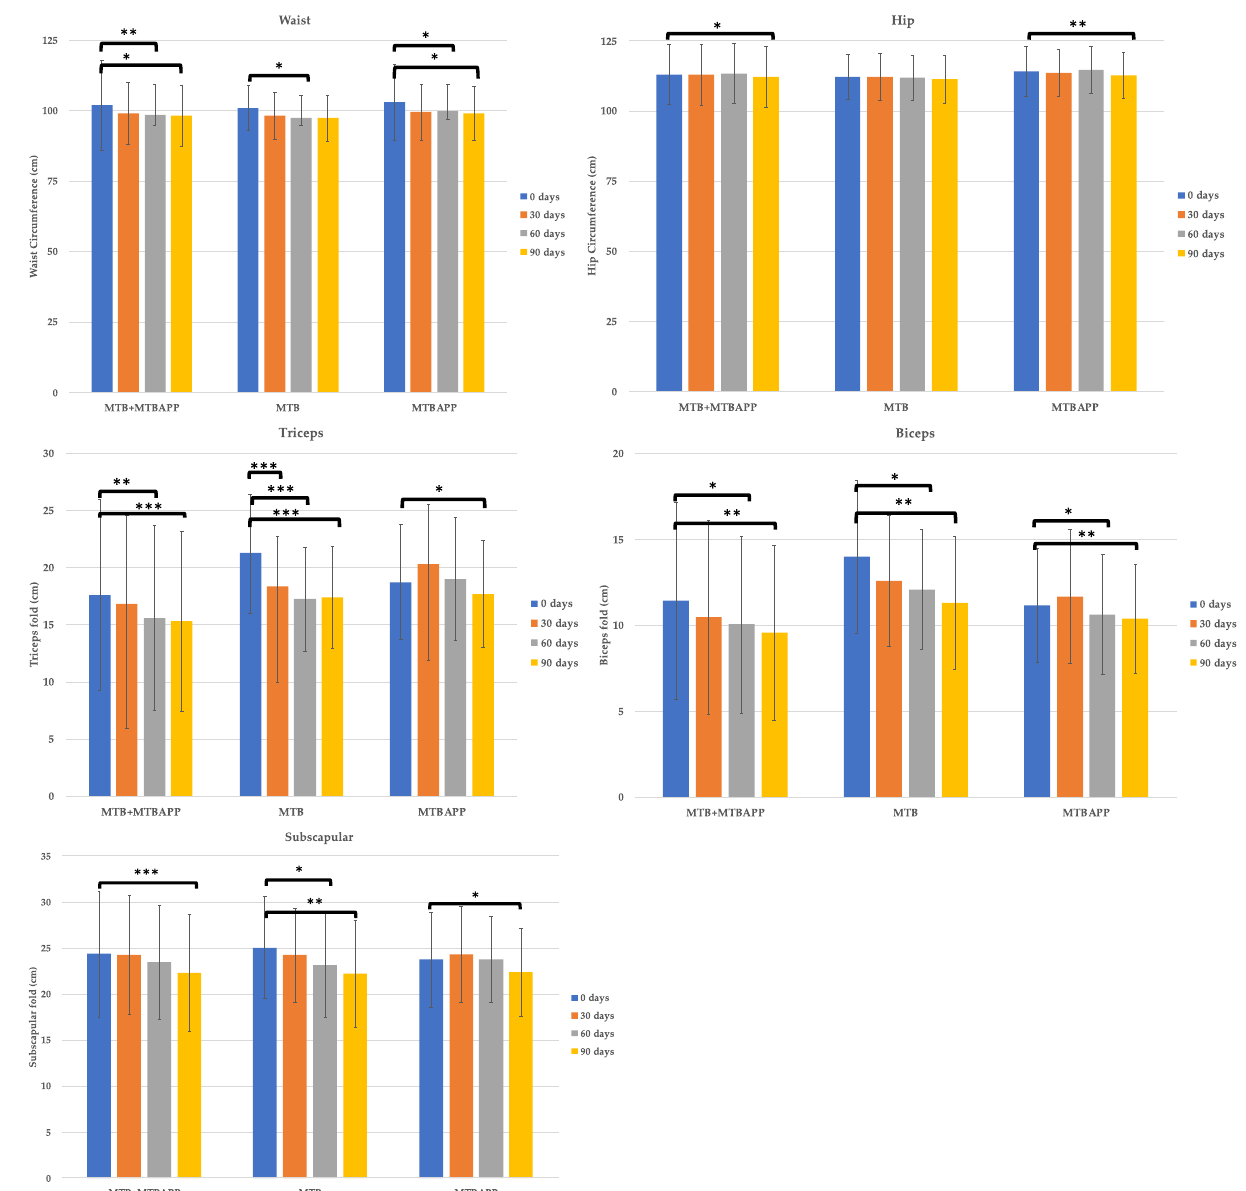
Figure 5. Anthropometric measurements. * p < 0.05, ** p < 0.01, and *** p < 0.005 by intragroup anal- ysis.